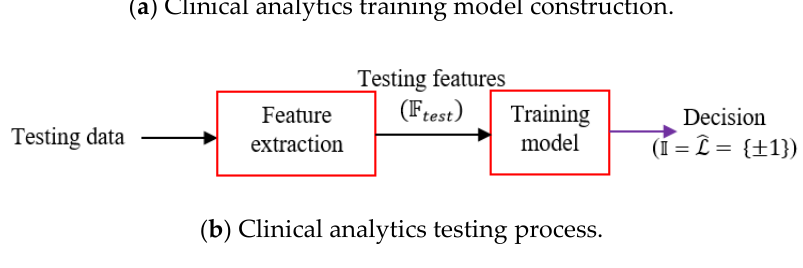
Figure 3. Clinical analytics approach.